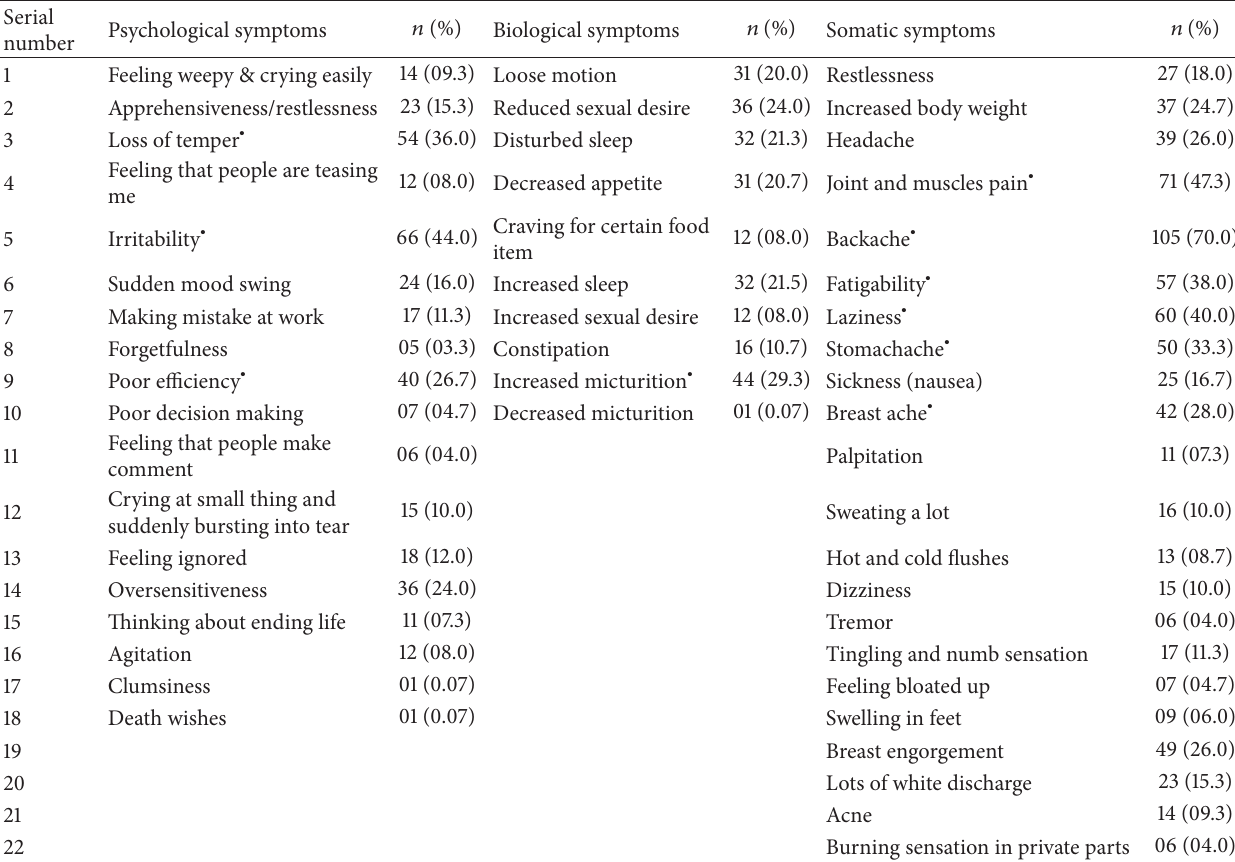
Table 2: Frequency and distribution of premenstrual symptoms ( 𝑁 = 150